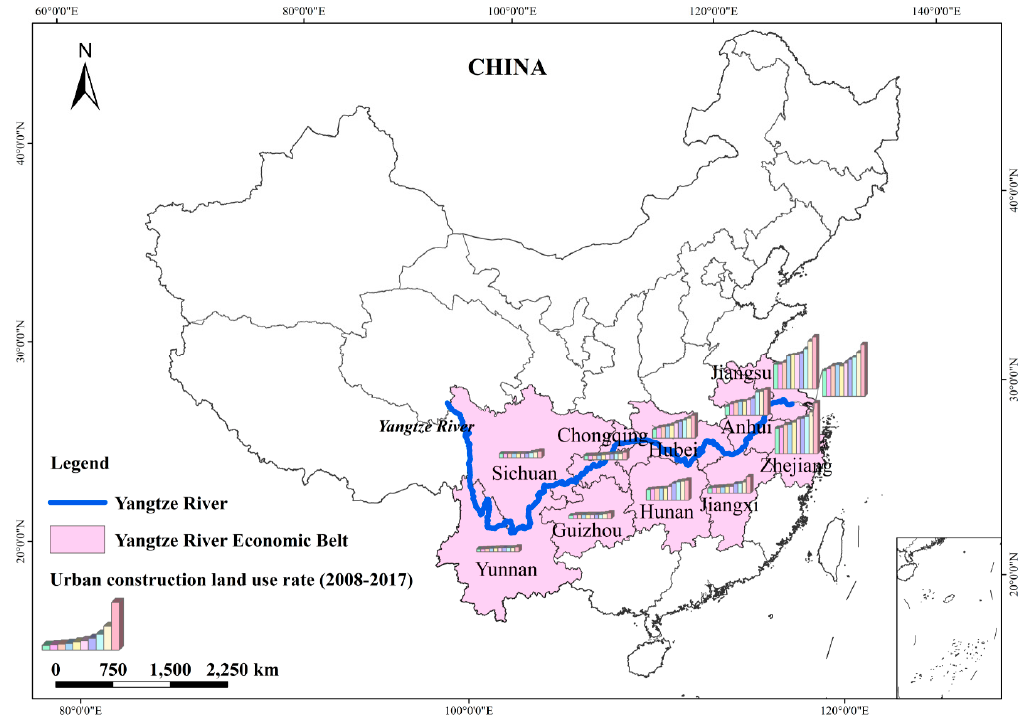
Figure 1. Yangtze River Economic Belt (YREB).